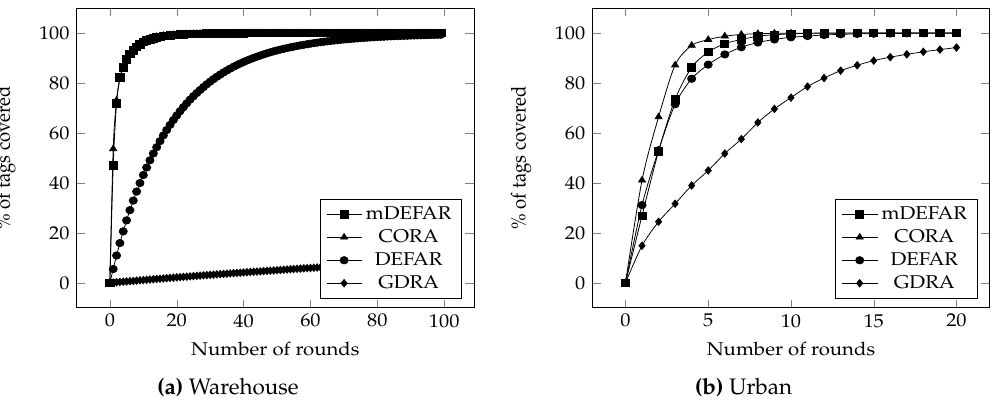
Figure 11. Coverage